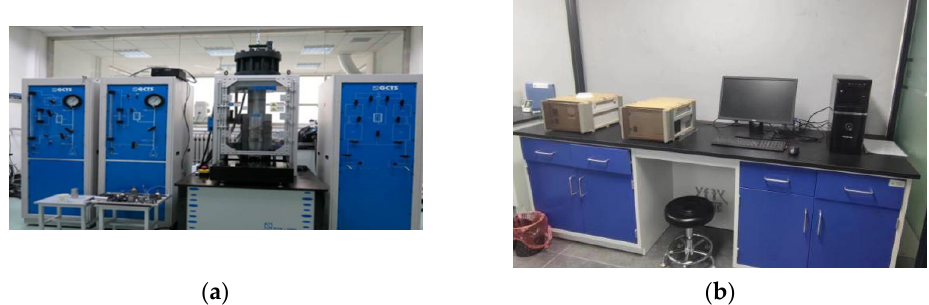
Figure 2. Test equipment. ( a ) RTR-1000 rock true triaxial mechanics test equipment, ( b ) RecCore- 2513DHNMR test equipment.